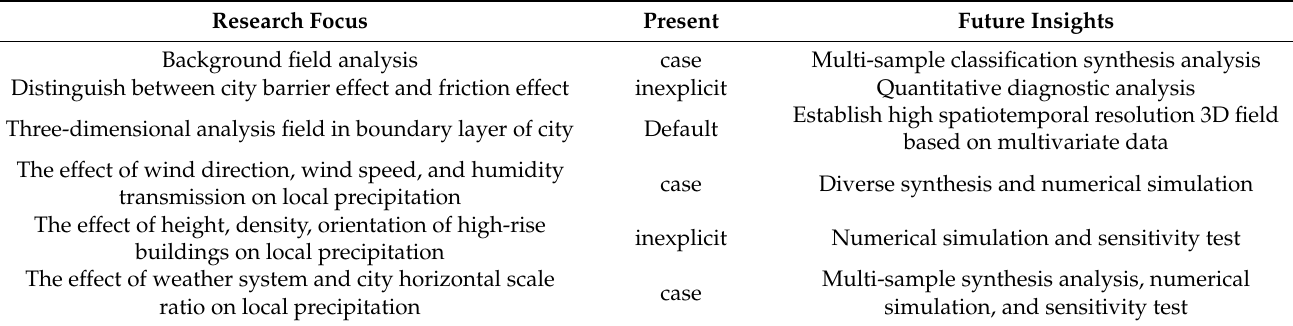
Table 2. Thoughts on dynamic effects of cities on